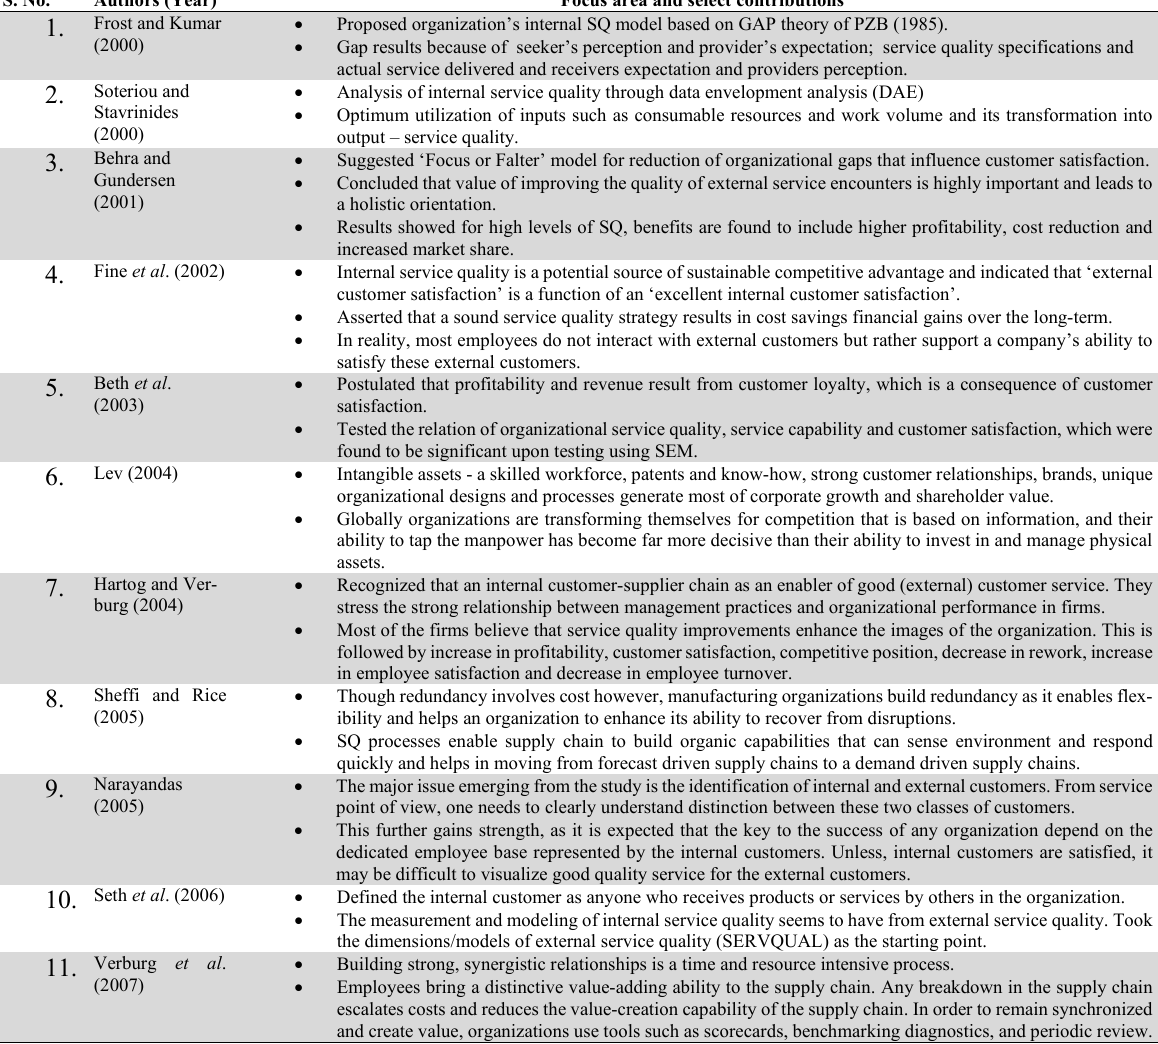
Key studies pertaining to Service Quality at Manufacturer-Distributor